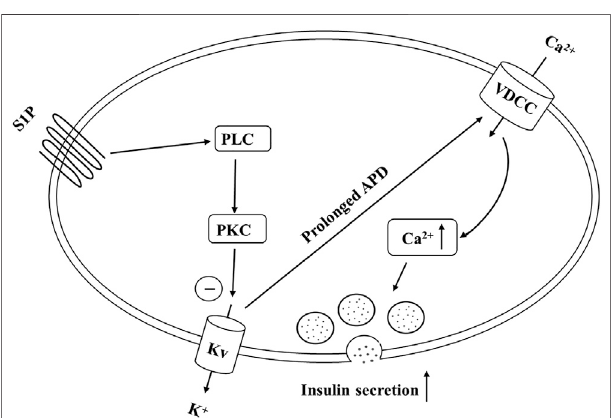
FIGURE 9 | Schematic of our proposed molecular mechanism by which sphingosine 1-phosphate (S1P) induces insulin secretion from pancreatic β cells. S1P inhibits voltage-dependent potassium (Kv) currents by activating the PLC/PKC pathway (rather than the adenylate cyclase (AC)/cAMP pathway), and not by direct suppression, thereby prolonging action potential duration (APD). This promotes Ca 2+ in fl ux and increases the intracellular Ca 2+ concentration, fi nally stimulating insulin